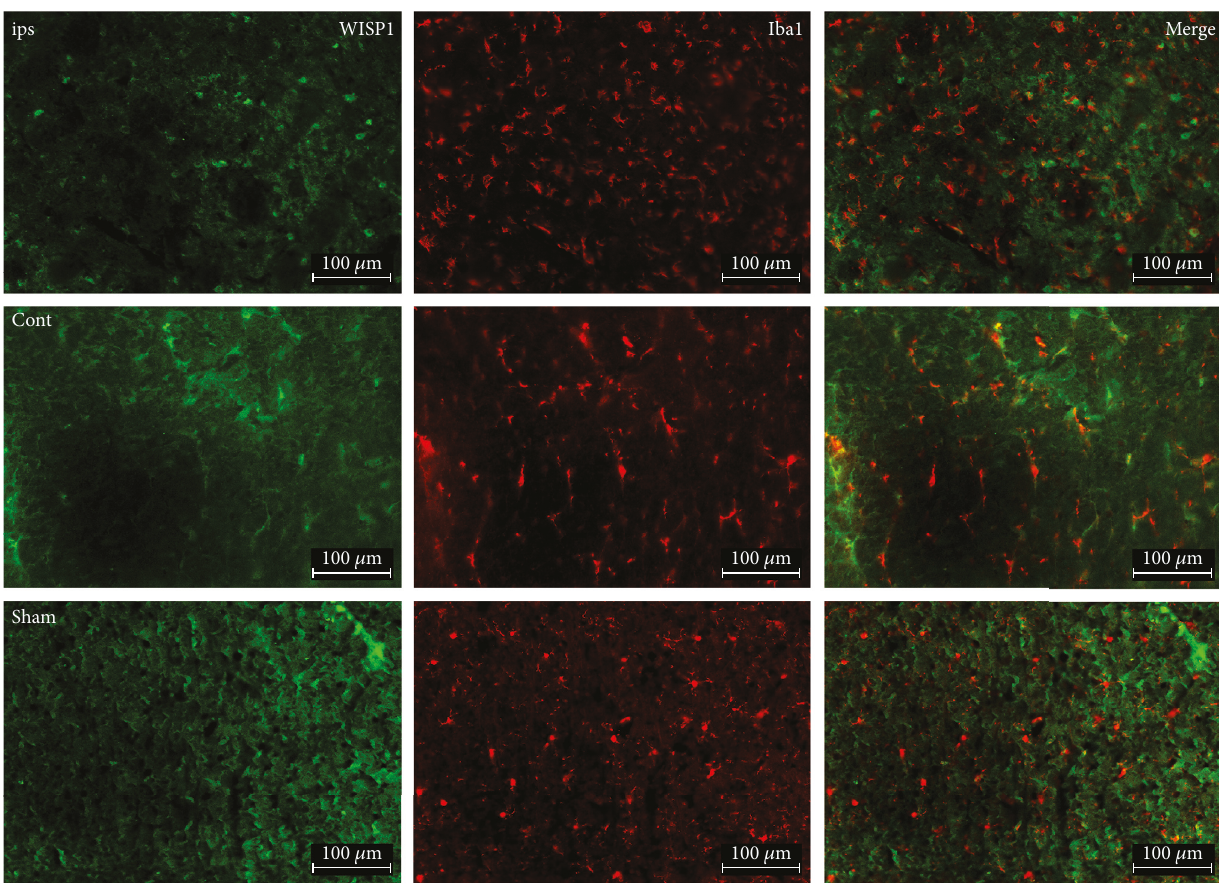
Figure 4: Double-labeling immuno fl uorescence of WISP1 and Iba1 at 3d after TBI. Green: WISP1; red: Iba1; cont: the control of ipsilateral 3d post-TBI group; ips: ipsilateral 3 d post-TBI group; sham: sham group; bar =100 μ